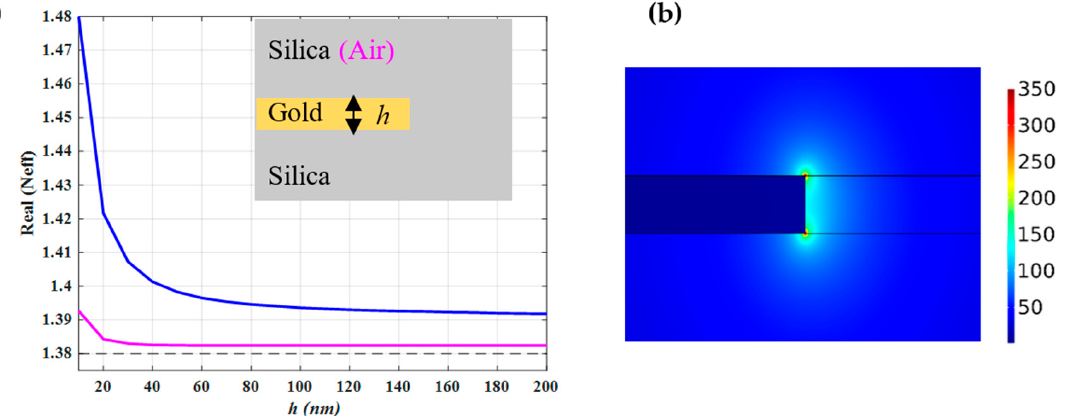
Figure 4. ( a ) The real parts of the effective mode index ( N ef f ) of the fundamental edge mode of a truncated gold layer when it is embedded as whole in the silica region (blue curve) and when the upper and lower cladding are air and silica, respectively (magenta curve). The dashed line represents the refractive index of the substrate. ( b ) The mode profile of the edge mode which is supported by a truncated gold embedded in silica where the gold thickness is 10 nm. The right-side rectangle in the picture is created to refine the mesh around the edge of the gold-silica interface.